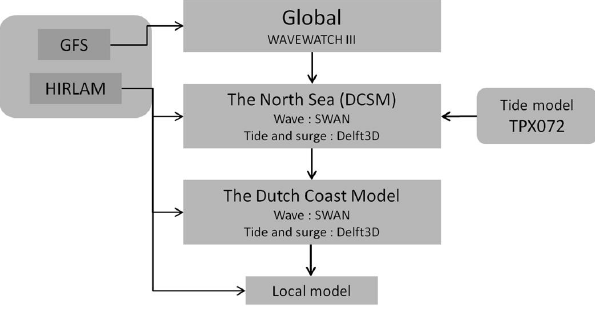
Figure 1. Model and domain structure within the Coastal Storm Modeling System – CoSMoS.